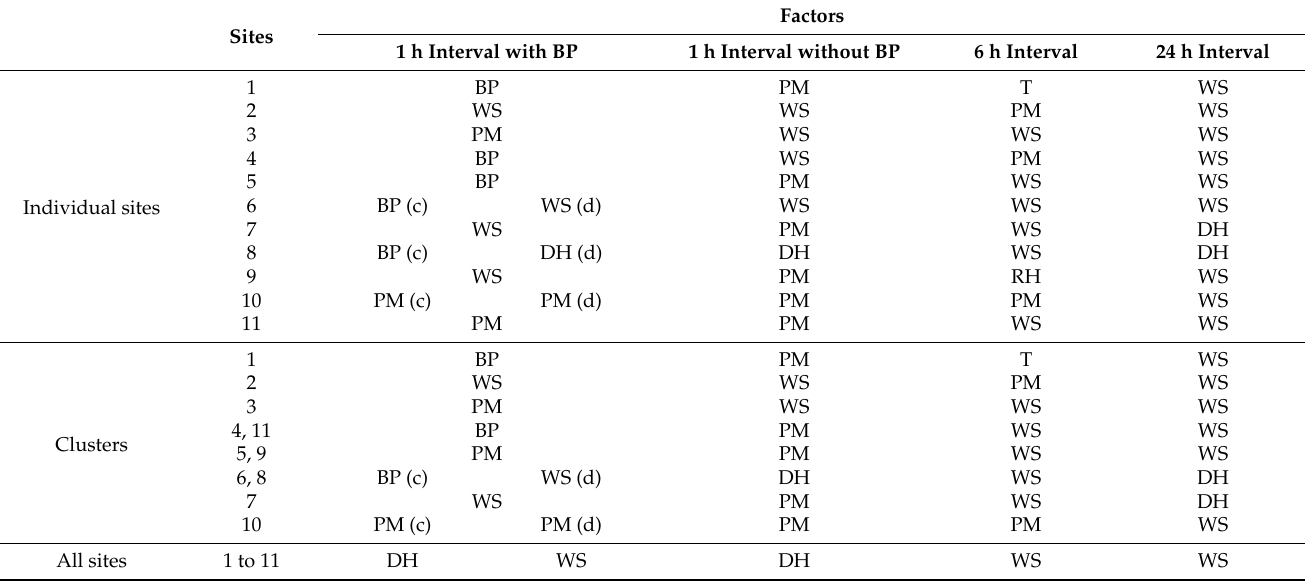
Table 10. Factors influencing the PM 2.5